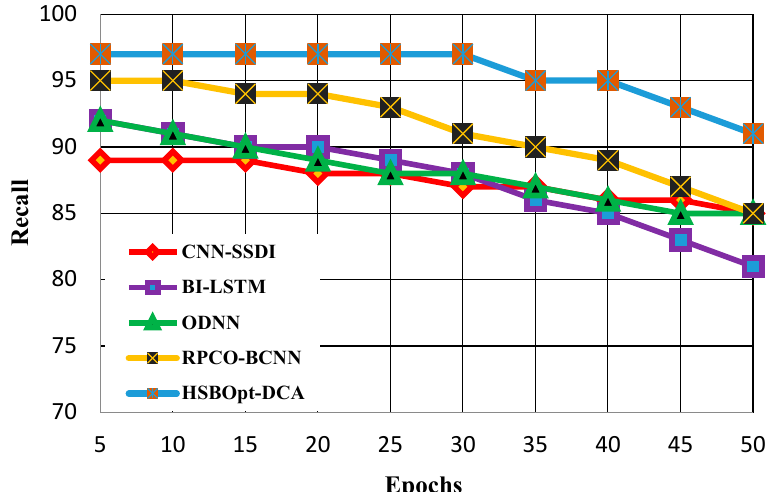
Figure 7. Recall calculation with 50 epochs.